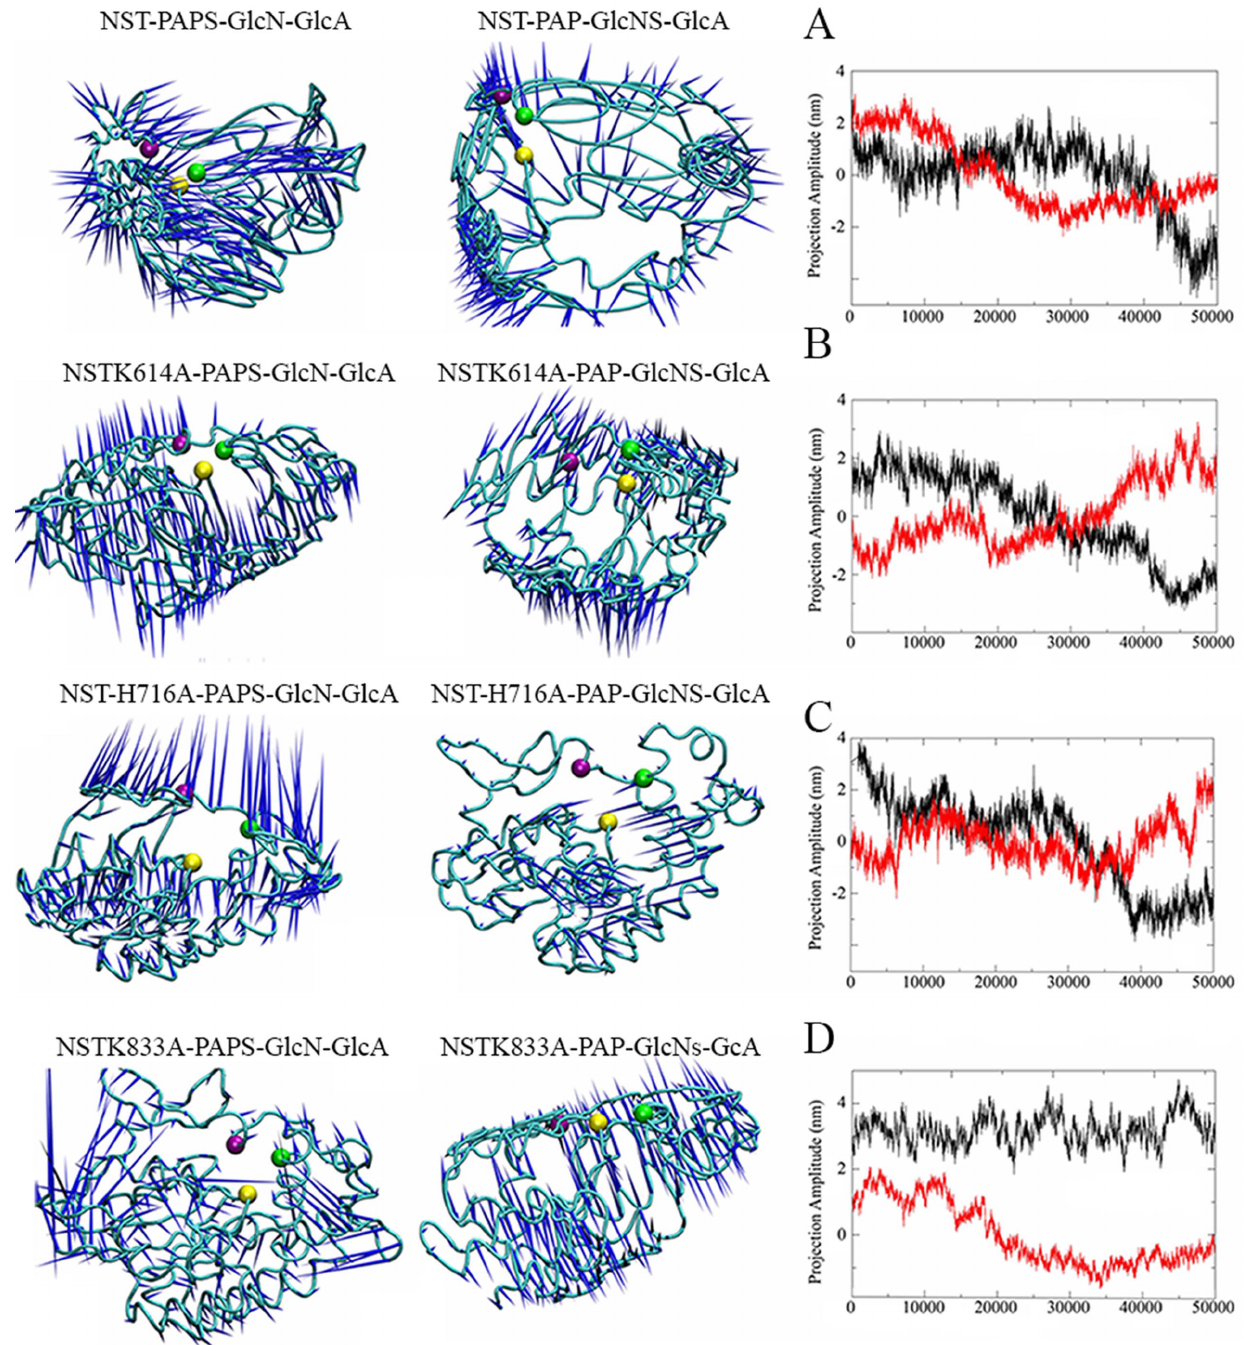
Figure 6. Effect of mutated residues in structural conformational changes. Computational dynamic analysis of NST is shown as cyan C a trace in each model. Porcupine plots showing the direction and amplitude of conformational changes between PAPS/GlcN-GlcA and PAP/GlcNS-GlcA states represented by the first eigenvector of the principal mode C a atoms calculated from the 50 ns simulation. The orientation of the blue cone indicates the direction of motion of the atom, and its length is proportional to the amplitude of the motion. Predicted binding residues are shown: yellow, Lys614; green, His716; and purple, Lys833. Right column: principal component analysis of combined MD trajectory of NST/PAPS/GlcN-GlcA and NST/PAP/GlcNS-GlcA and mutants. Projection of the MD trajectories on the first eigenvector of the covariance matrix of C a atoms. Black, projections of the first 50 ns of the combined trajectory NST-PAPS-GlcN-GlcA; red, projections of the 50 of the combined trajectory NST-PAP-GlcNS- GlcA. N-sulfotransferase domain and Lys614, His716 and Lys833 are represented in figures A-D.